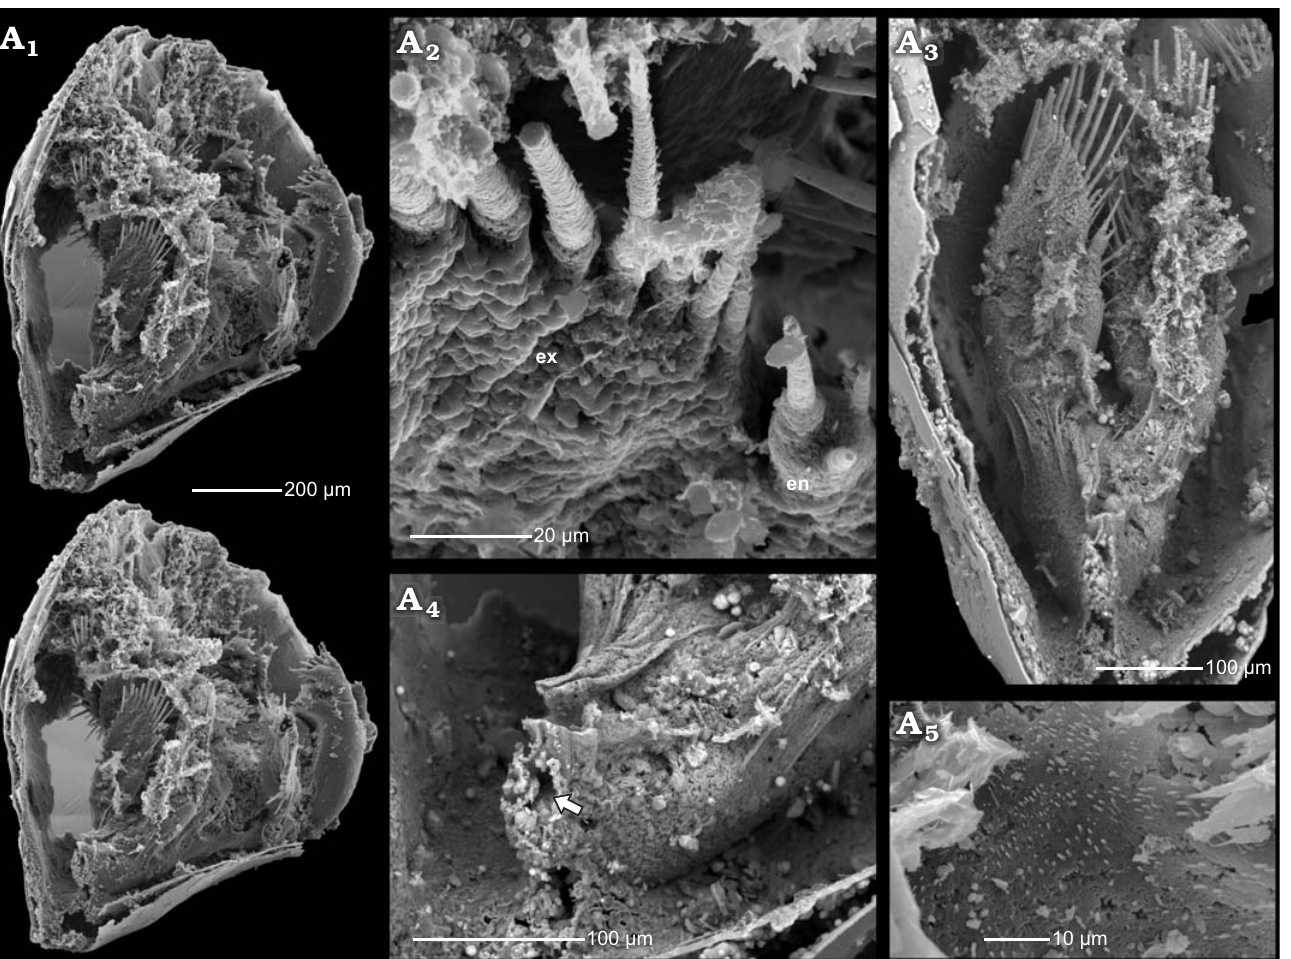
Fig. 6. Phosphatocopid crustacean Cyclotron angelini (Linnarsson, 1875), ZPAL Cr.11/ph060 from the Olenus Biozone, Furongian, D ę bki 2 borehole, northern Poland. Stereo-pair in postero-lateral view with 7th limb (A 1 ); detailed view of distal part of 7th limb in poster-ventral view, exhibiting membra- nous wall and setulose setae of the exopod, note tiny endopod in postero-ventral view (A 2 ); details of 7th limb in posterior view, note arthrodial membrane in distal part (A 3 ); posterior part of the body proper with possible anus (arrow) (A 4 ); detailed view of sternum surface covered with fine setules (A 5 ). Abbreviations: en, endopod; ex,